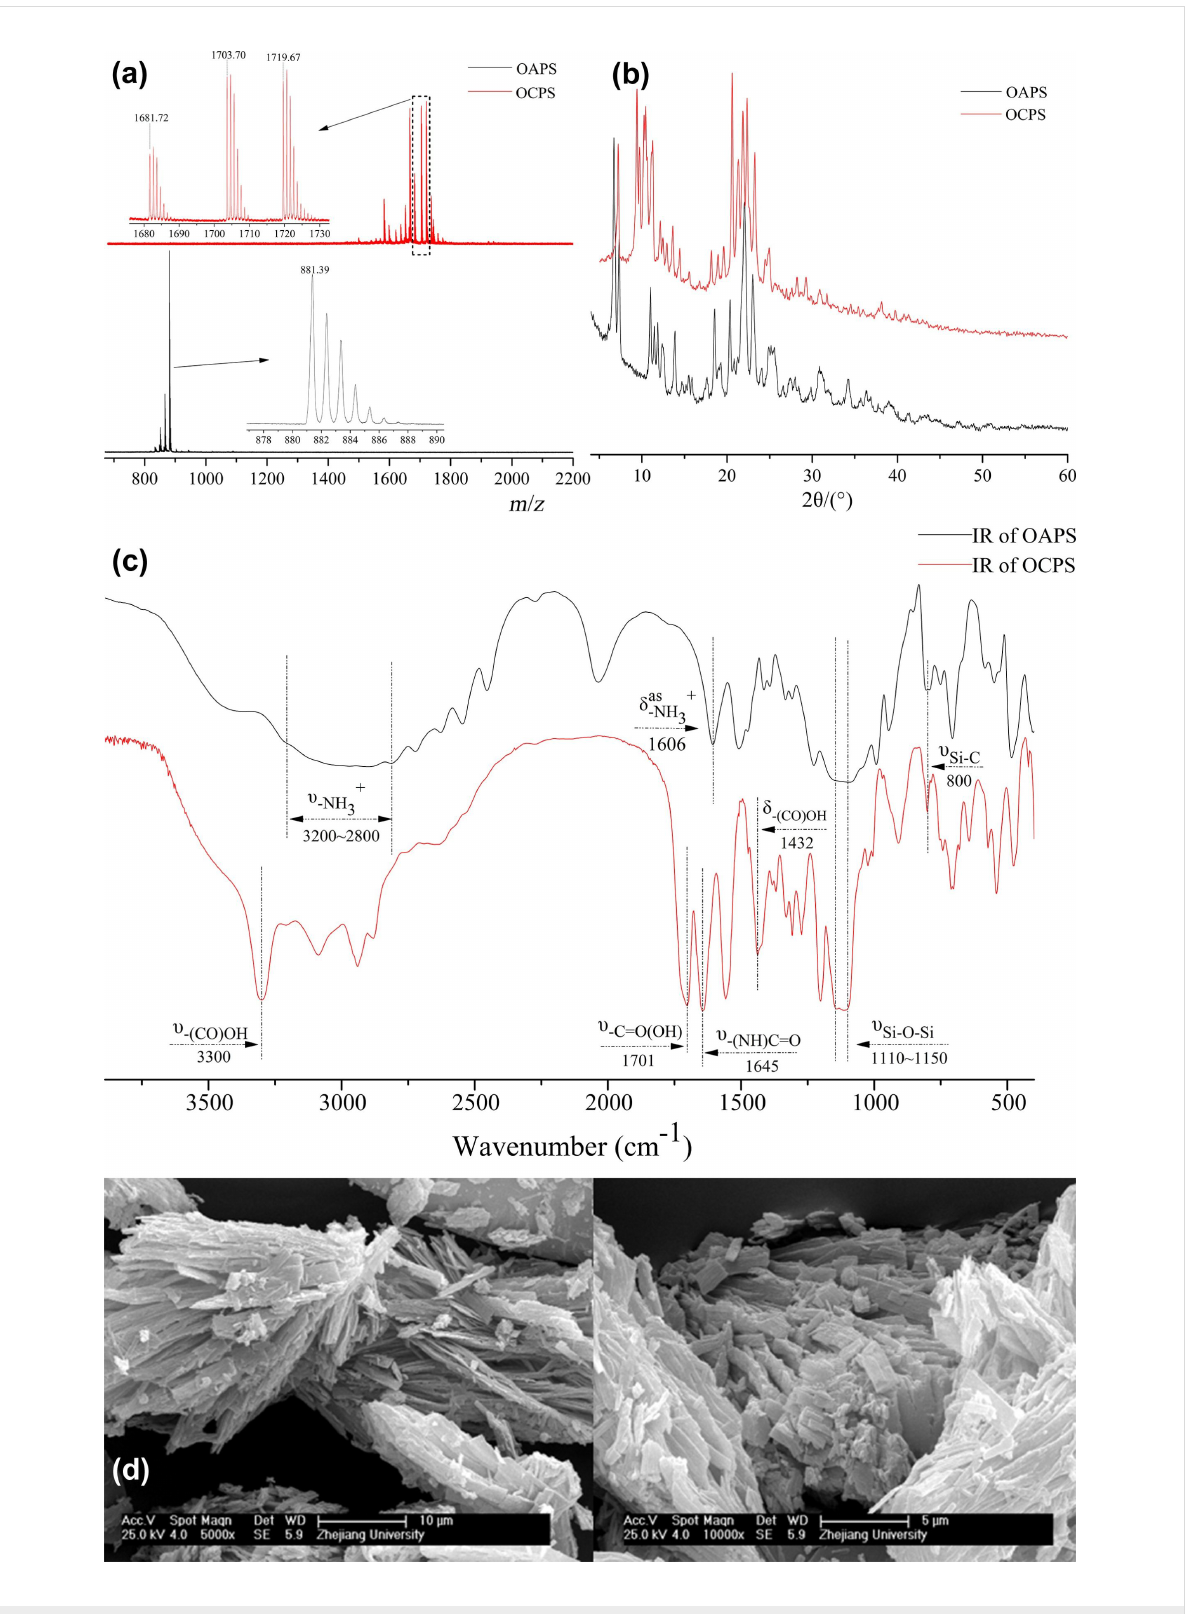
Figure 3: (a) MALDI-TOF-MS spectra, (b) XRD patterns and (c) FTIR spectra of OAPS and OCPS; (d) SEM images of